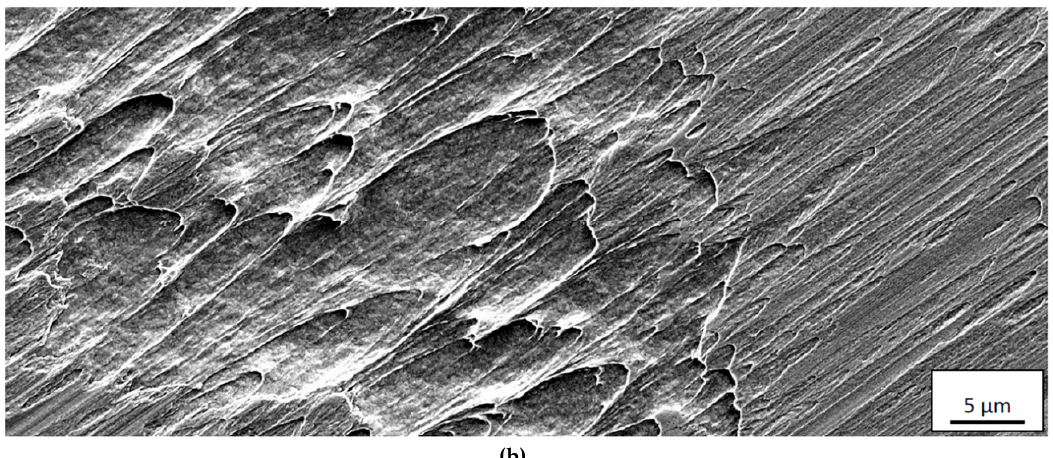
Figure 13. Surface morphology of back side, i.e., the surface in contact with the rake face, of Ti6Al4V chip showing signs of repeated bands revealing the presence of a strong adhesive contact between the chip and the tool rake face at lower magnification ( a ) and higher magnification ( b ). The arrow indicates the chip flow direction.